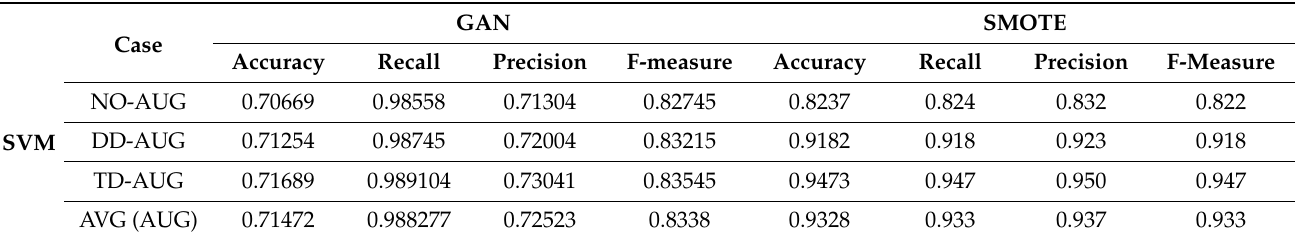
Table 2. Evaluation of SVM Classifier for NO-AUG, DD-AUG and TD-AUG.